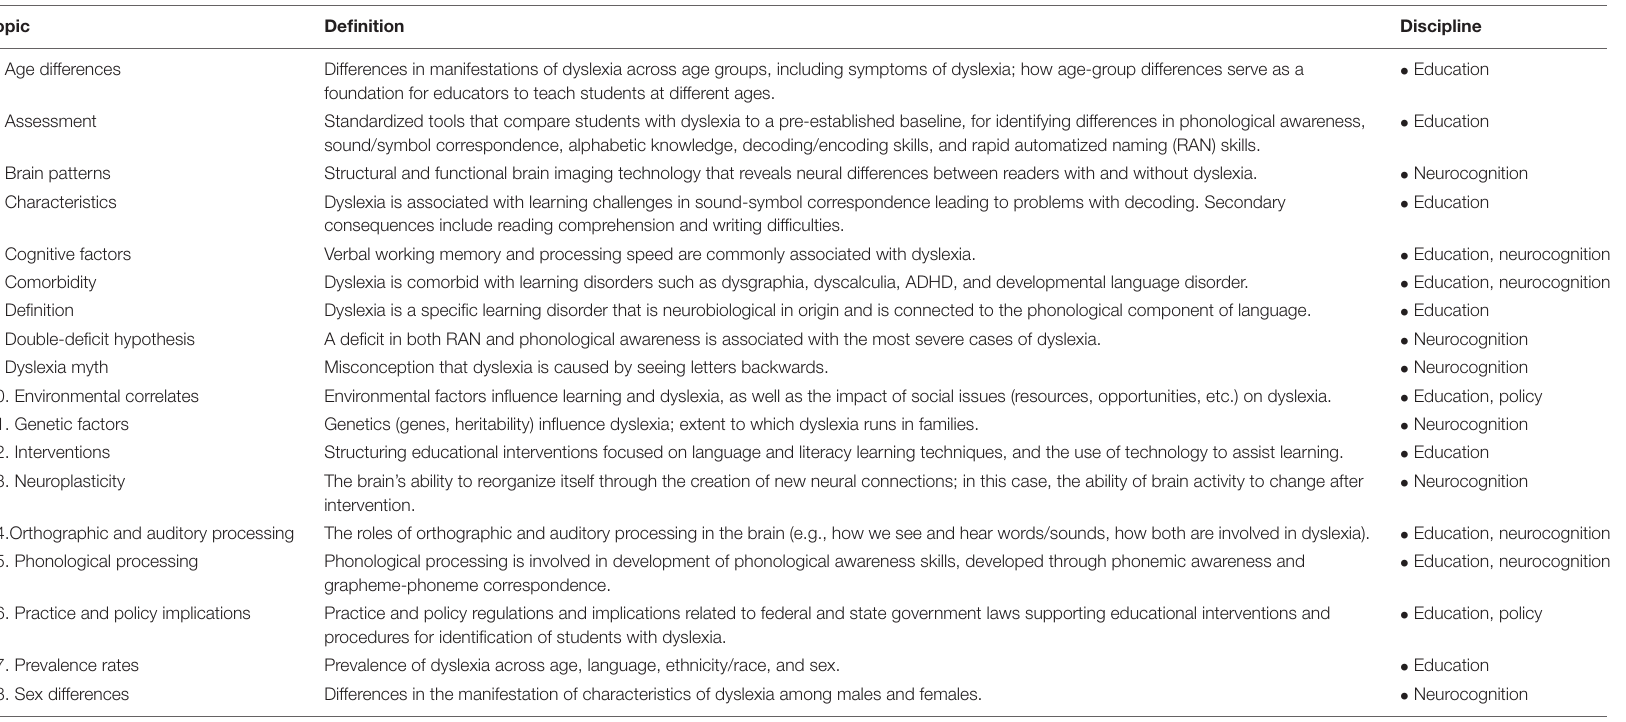
TABLE 1 | Coded dyslexia module topics, definitions, and disciplinary categories. Topic Definition